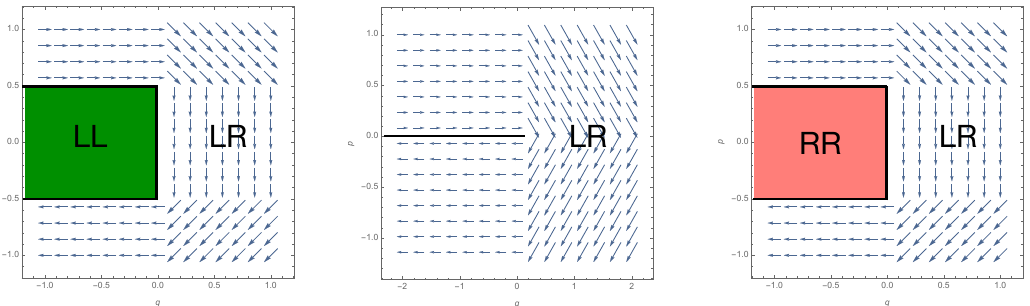
Figure 2. Hamiltonian flows of the zigzag model in the ( p, q ) plane at P = − 1 (left panel), P = 0 (middle panel) and P = 1 (right panel). Topological sectors corresponding to different values of the charge T are labeled as LL , RR and LR . The vector field vanishes in the free LL and RR